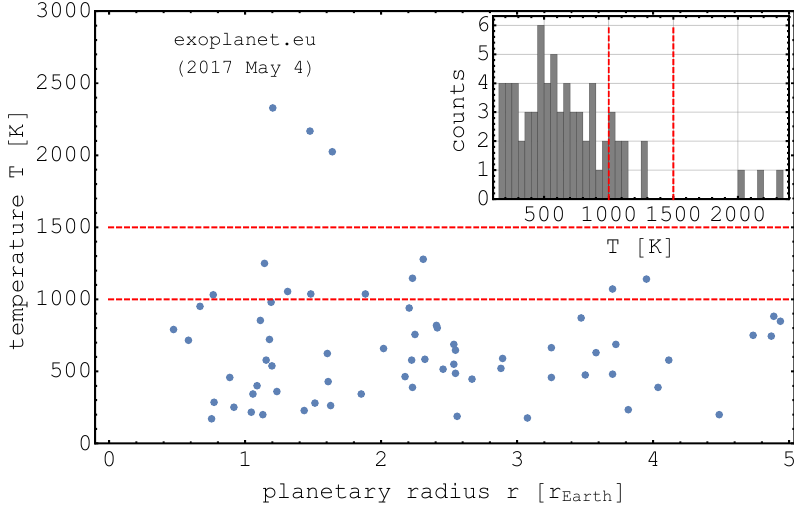
Figure 6. The occurence of small extrasolar planets depending on orbit temperature. The lines mark the sticking transition observed in experiments at 1000 K and the limit of sublimation. The inset shows the same data as a histogram over temperature (from Demirci et al.